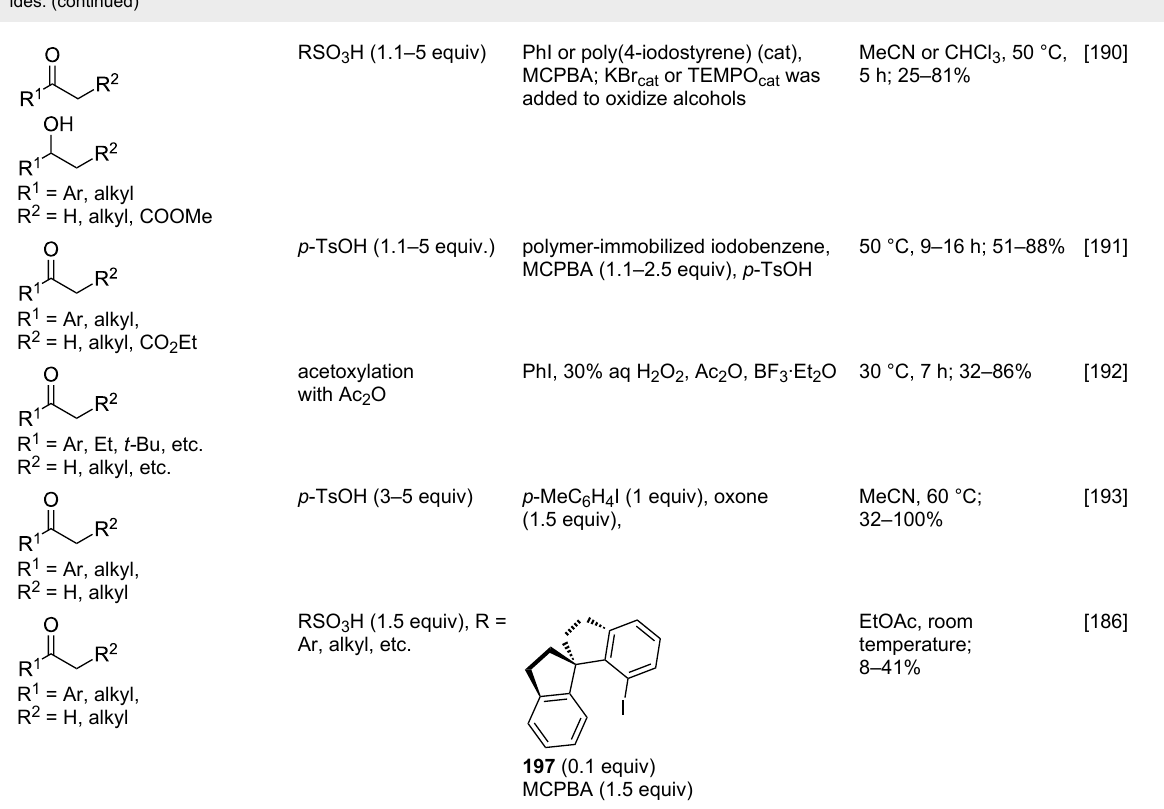
Table 6: C–O coupling reactions at the α -position of carbonyl compounds mediated by iodine(III) compounds or iodoarenes in the presence of perox- ides. (continued)